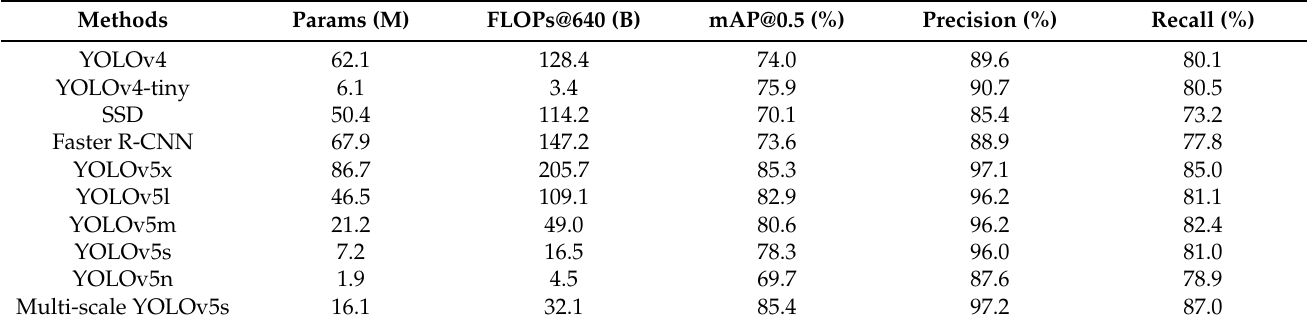
Table 6. Comparative experiment with the current mainstream